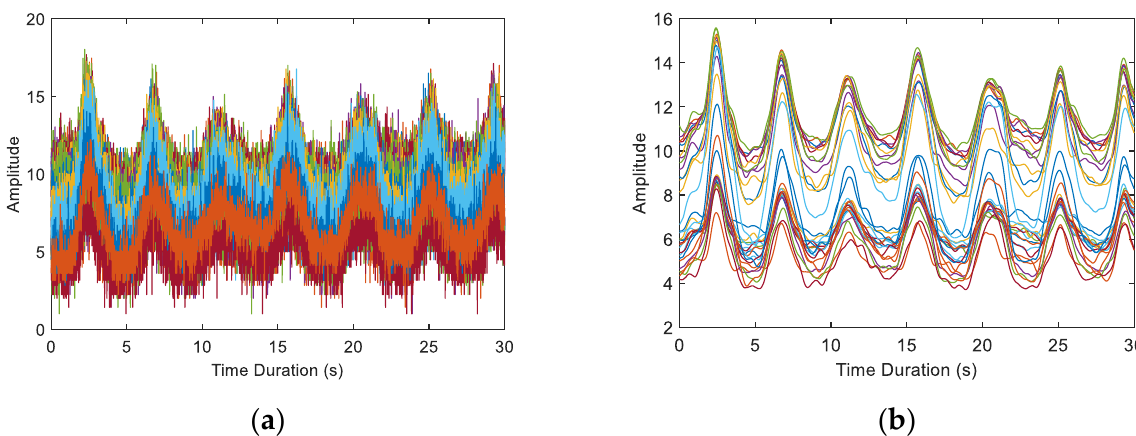
Figure 6. CSI amplitude of 30 subcarriers before and after data calibration. ( a ) Raw CSI amplitude. ( b ) CSI amplitude after calibration.